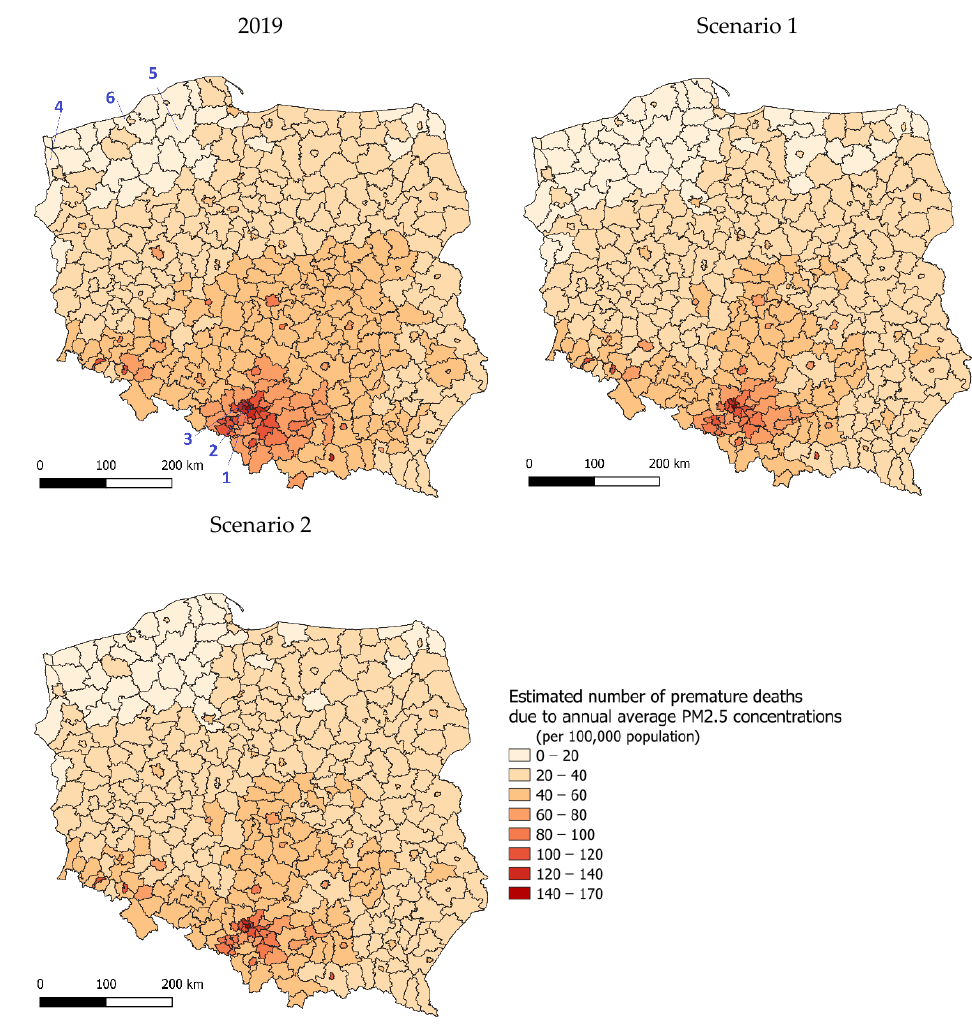
Figure 6. Estimated number of premature deaths due to annual average PM2.5 concentrations in 2019, as projected for scenario 1 and scenario 2; per 100,000 population; counties averages. Numbers 1 – 6 refer to the counties presented in detail in Table 2. Table 2. Counties with the highest estimated number of premature deaths due to annual average PM2.5 concentrations (per 100,000 population) in 2019 and based on scenario 1 and scenario 2 forecasts. The counties are shown on the map (Figure 5) numbered from 1 to 6.